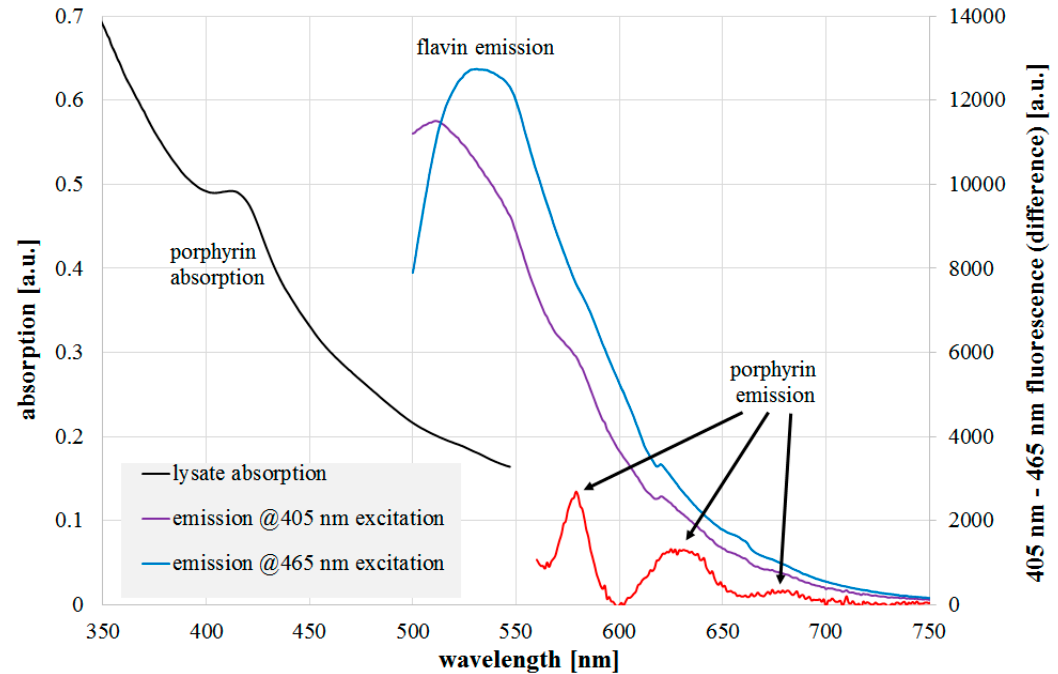
Figure 3. L. rubrilucens lysate absorption (black line), fluorescence emission at 405 nm (violet line), 465 nm excitation (blue line), and difference of normalized emissions (red line). The assumed peak origins are also given.